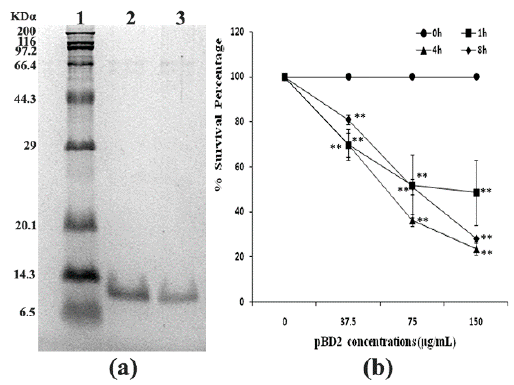
Figure 1. Purified fused pBD2 and its antimicrobial activity. ( a ) SDS-PAGE analysis of purified fused pBD2. Lane 1 indicates the protein marker; Lanes 2–3 indicate purified pBD2. ( b ) Antimicrobial activities of recombinant pBD2 against S. aureus at different time points. The ** symbol indicates extremely significant differences compared with the control at p < 0.01 by Dunnett’s method.